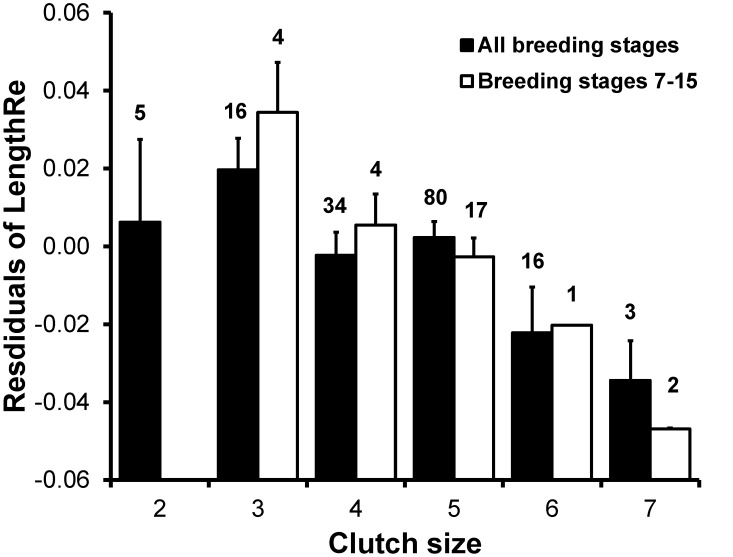
Mean (±SE) residual growing R4 length in relation to clutch size.Mean (±SE) residuals of LengthRe (see Methods) of females from models including breeding stage and date in relation to clutch size, for all breeding stages or for breeding stages ranging between 7 and 15 (see Results). Numbers above bars indicate sample sizes.